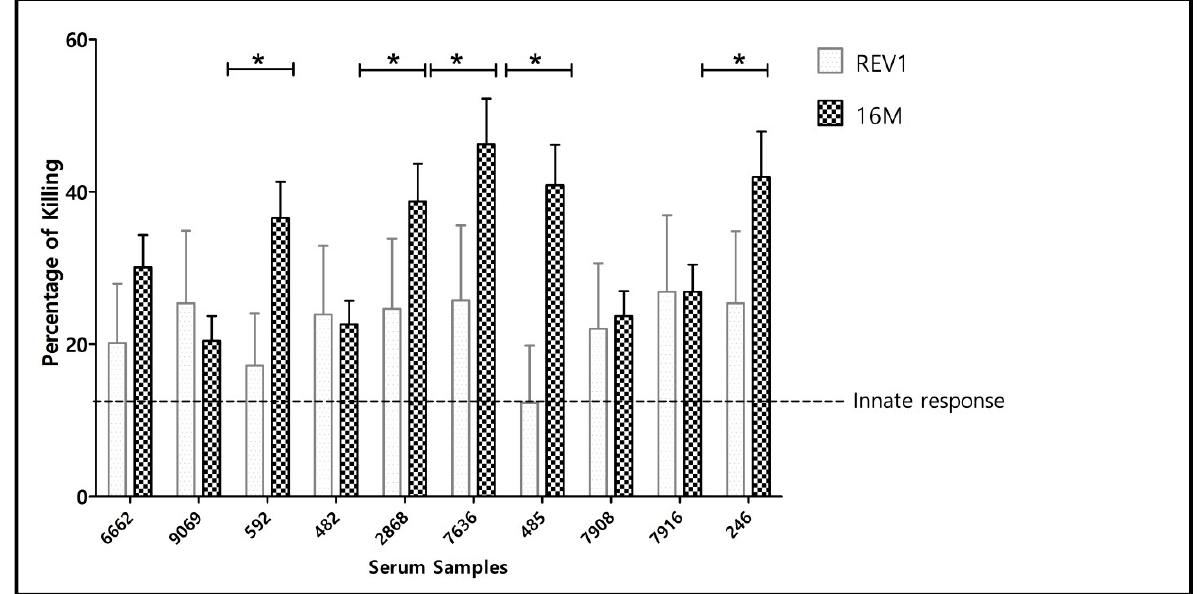
Figure 4. Percentage of cell killing of B. melitensis strain 16M and B. melitensis strain Rev1 Elberg by serum samples of infected sheep. Unpaired T -test shows overall significant difference between 16M and Rev1 cell killing ( p < 0.05) (with Bonferroni correction for multiple comparisons), (* p < 0.05) shows the significant difference in the killing activity of individual sera. Horizontal line depicts percentage of Brucella cell killing attributed to innate immunity (A generalized innate killing activity of sheep serum samples calculated as a mean value of killing results of the four serum samples prior to animal vaccination). Killing activity above this level is considered, therefore, to be contributed by any of anti- Brucella antibodies present in the reaction, including non-anti-OPS antibodies.